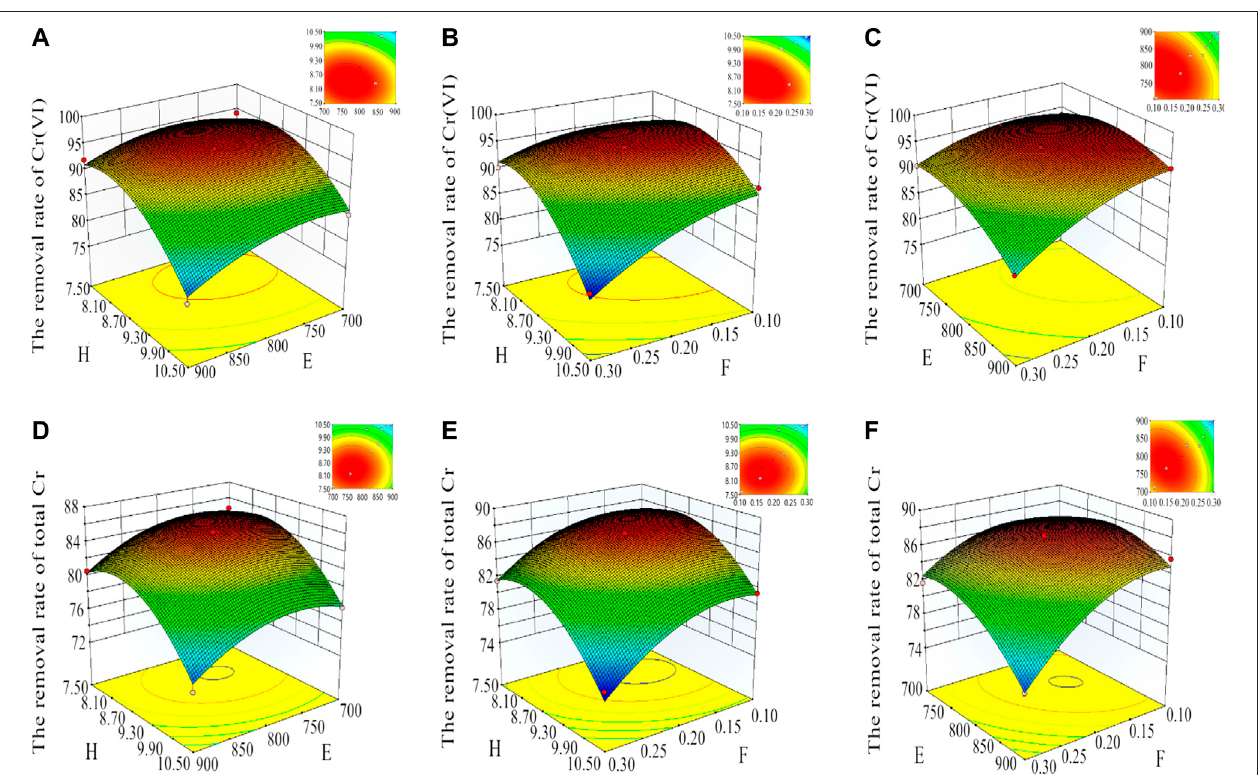
FIGURE1| Theresponsesurfaceplotsandcontourplotsthatmutuallyin fl uencefactorsfortheremovalrateofT Cr andCr(VI). (A – C) areforCr(VI),and (D – F) arefor T Cr (A, B, C, D, E, F, G, and H were set at the concentration of KOH (mol/L), MBC carbonization temperature ( o C), MBC carbonization time (h), MBC soaking time with KOH (h), MBC activation temperature after soaking in KOH solution ( o C), Fe/Mn concentration (C Fe , C Mn ) (mol/L), reaction time (h), and the pH during precipitation of Fe- Mn oxide,